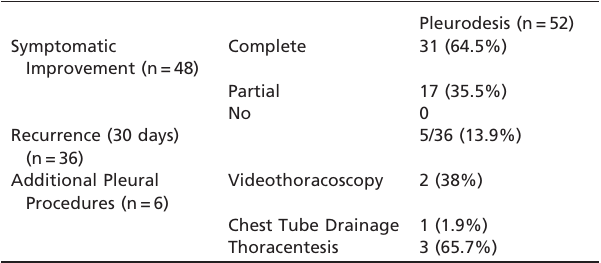
Table 1 - Characteristics of the patients elected for chest drainage.